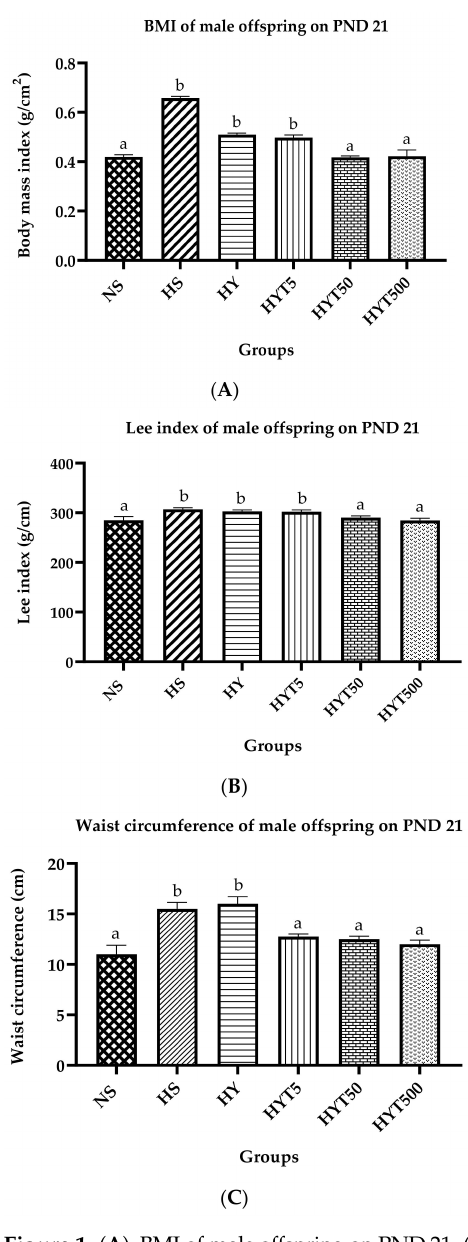
Figure 1. ( A ). BMI of male offspring on PND 21. ( B ). Lee index of male offspring on PND 21. ( C ). A waist circumference of male offspring on PND 21. Different letters indicates a significant difference at p <